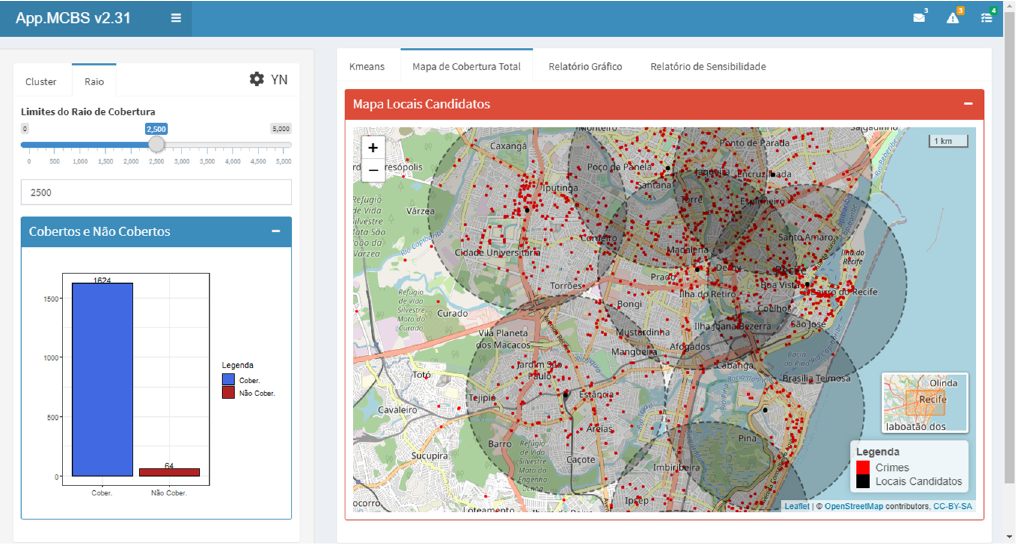
Figure 5. Local candidates screen.